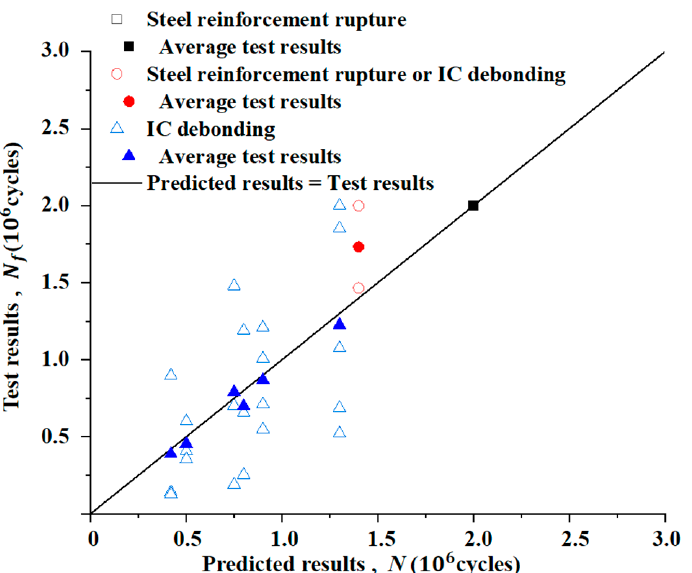
Figure 10. Comparison of the tested and predicted fatigue lives.